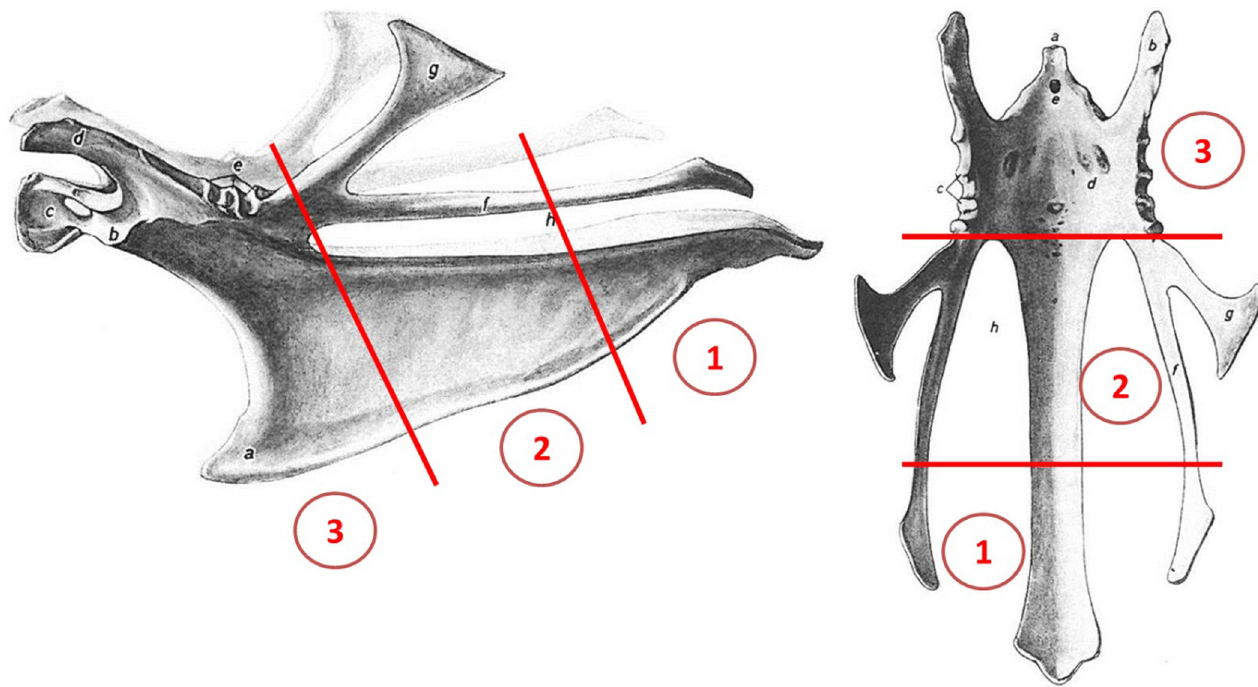
Fig 2. Lateral and dorsal (visceral) aspect of the keel bone of the adult chicken. Sections of the keel bone 1) the caudal part (including the tip, processus xiphoideus); 2) the middle part; and 3) the cranial part (including carina sterni). Modified after